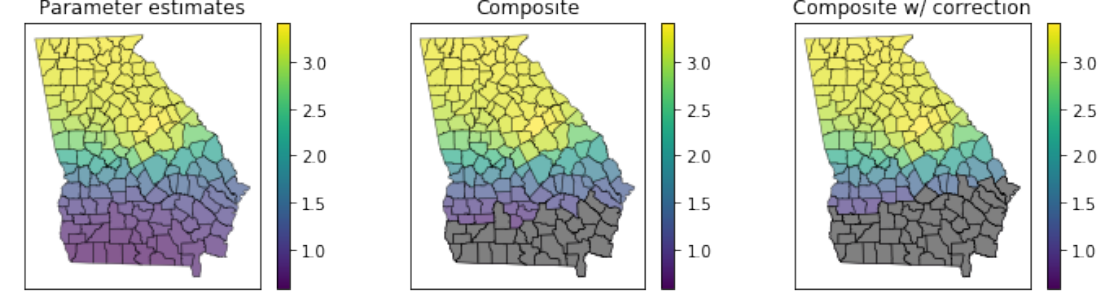
Figure 7. Parameter estimates for foreign born variable ( left ), composite of significant and insignificant (grey) parameter estimates without correction for multiple dependent hypothesis tests ( middle ) and with correction for multiple dependent hypothesis tests ( right